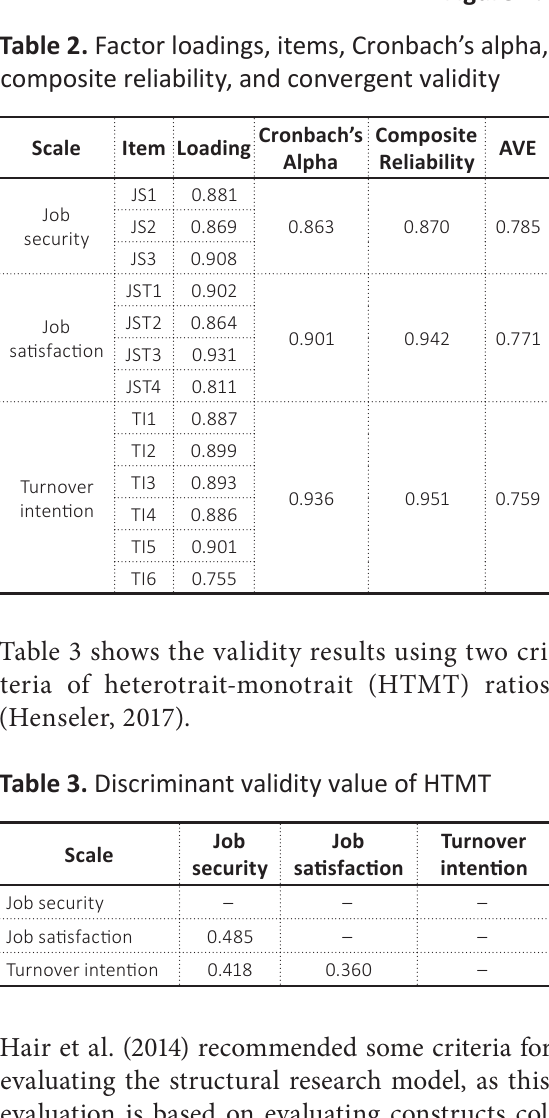
Figure 2. Initial